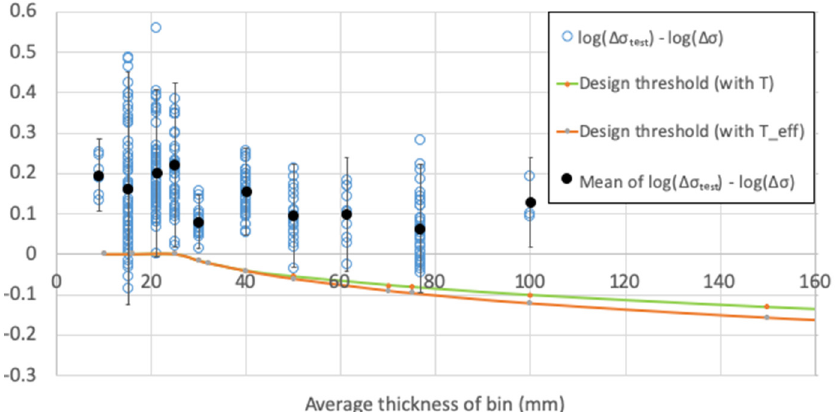
Figure 14. Data analysis of in-air transverse butt-welded joints .